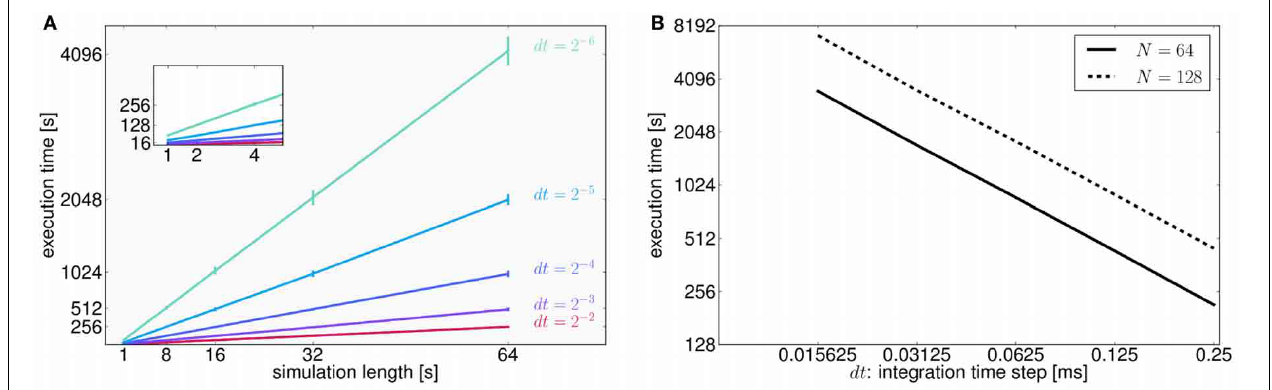
FIGURE 7 | (A) As expected for fixed time-step schemes, execution times scale linearly with the number of integration steps. We used seven values of simulation lengths (1, 2, 4, 8, 16, 32, and 64 s) and five values of integration time step ( dt = 2 − 2 = 0 . 25 , dt = 2 − 3 = 0 . 125, dt = 0 . 0625 = 2 − 4 , dt = 0 . 03125 = 2 − 5 , and dt = 0 . 015625 = 2 − 6 ms). For each possible combination 100 simulations were performed. The network model consisted of 74 nodes (with two state variables and one mode per node). Numerical integration was based on Heun’s stochastic method. We plot the average execution time with the error bars representing the standard deviation over simulations. The inset shows a narrower range for simulation lengths between 1 and 4s. Axes units